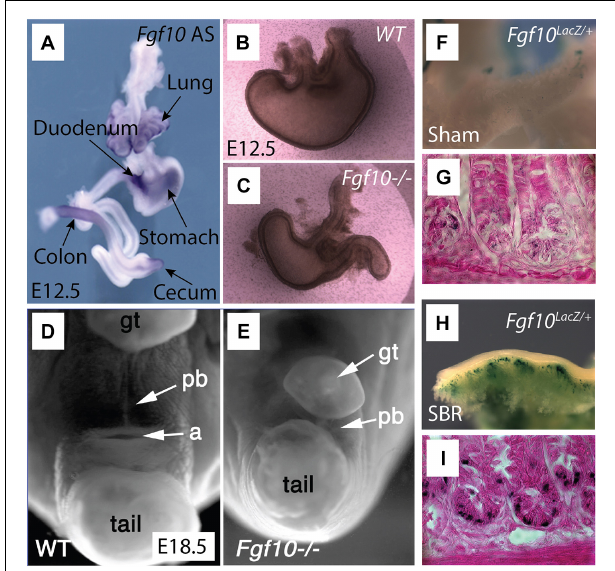
FIGURE 2 | Overview of Fgf10 expression and associated Fgf10 KO malformations in the gastrointestinal tract. Adapted under CC-BY 4.0 license, from Burns et al. (2004); Fairbanks et al. (2004), Spencer-Dene et al. (2006), and Tai et al. (2009). (A) Whole mount in situ hybridization tracing the expression of Fgf10 (Antisense) in E12.5 gut. Fgf10 is expressed in the lung, duodenum (arrow points out to the pyloris located at the junction between stomach and duodenum), colon, stomach, as well as cecum. (B,C) Fgf10 KO embryos display stomach dysplasia (C) compared to wild type (WT) mouse (B) . (D,E) Fgf10 KO embryos (E) display smaller perineal body (pb), with indistinguishable anus in E18.5 compared to the WT mouse (D) . (F–I) A small bowel syndrome (SBR) was induced in Fgf10 LacZ / + mice. The Fgf10 LacZ / + mouse displayed increased β -galactosidase (a readout for Fgf10 expression) in the area of small intestine (H) and the crypts (I) of the ileum after small bowel resection (SBR) compared to the Sham group (F,G)